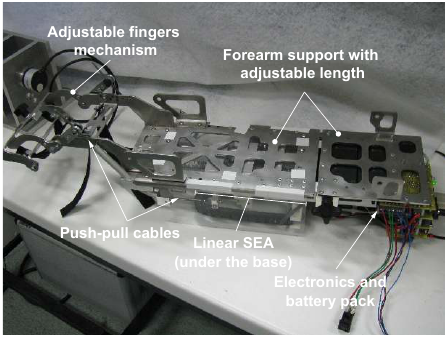
Figure 3. The slave